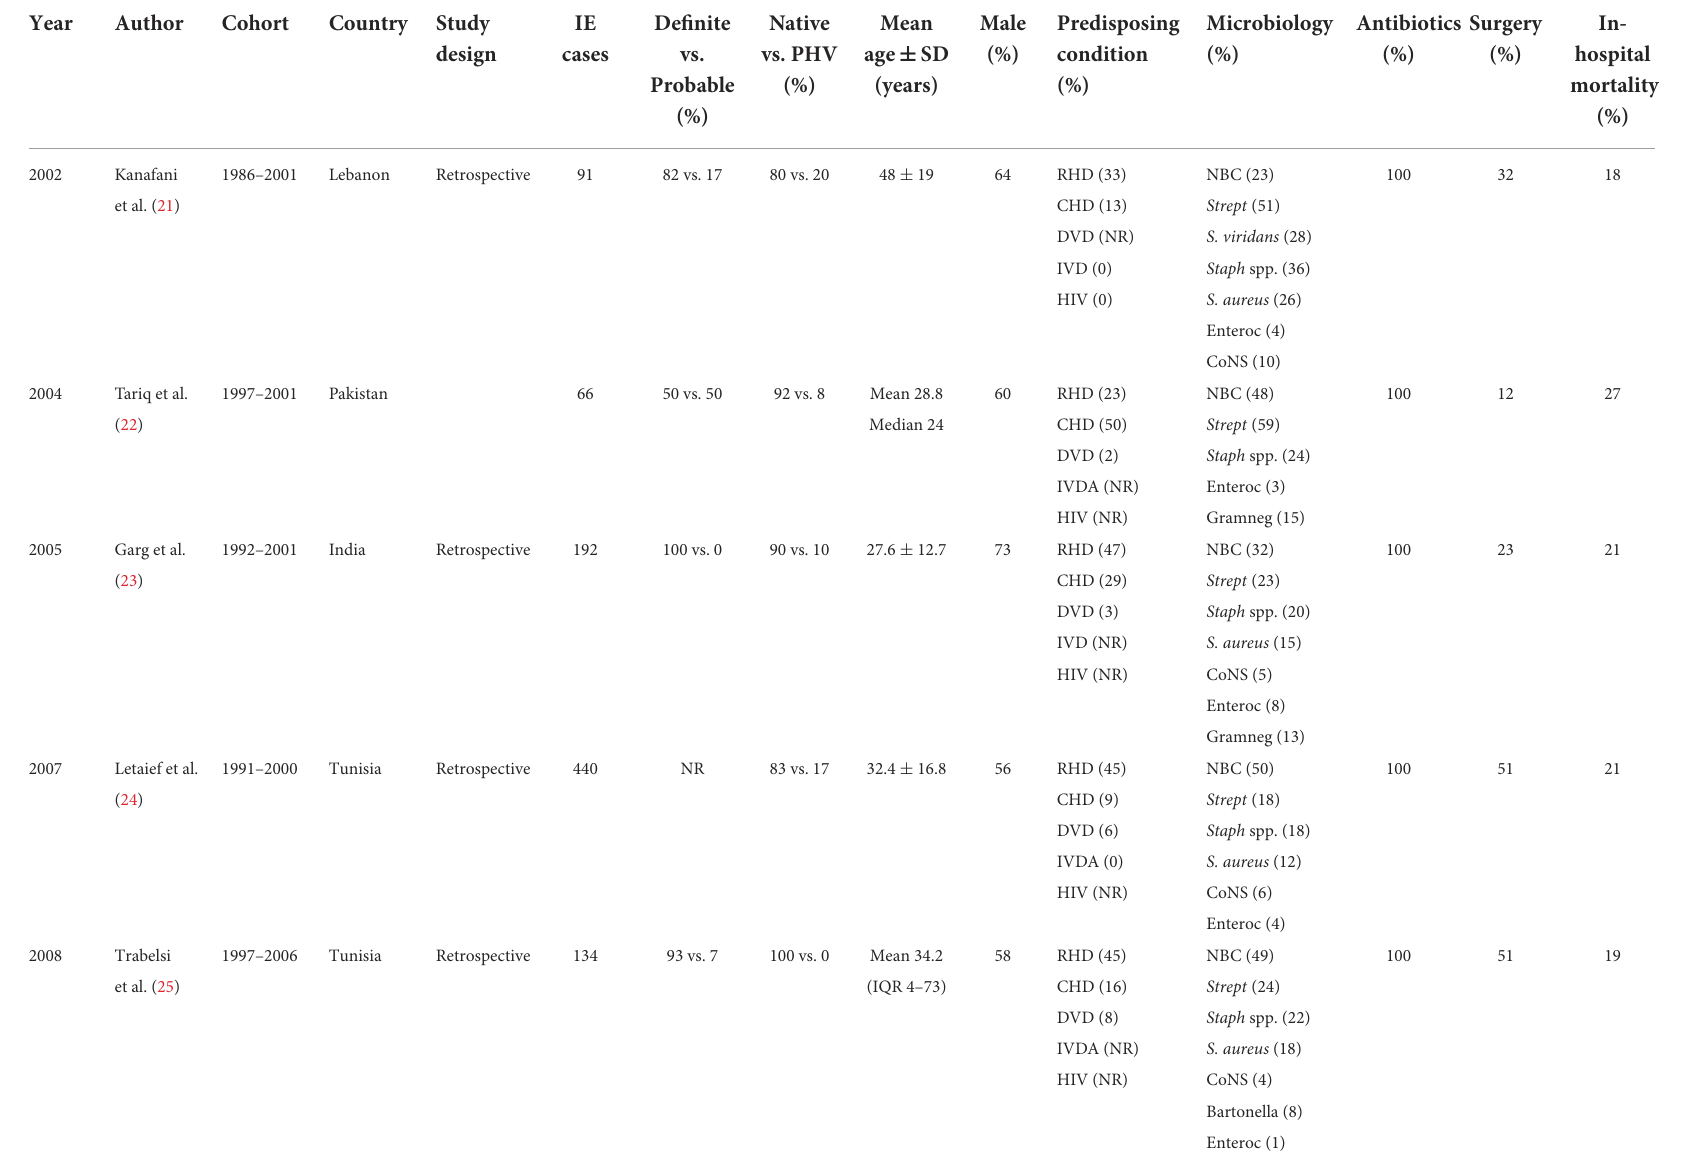
TABLE 1 Characteristics of the study population of group 1, publications before